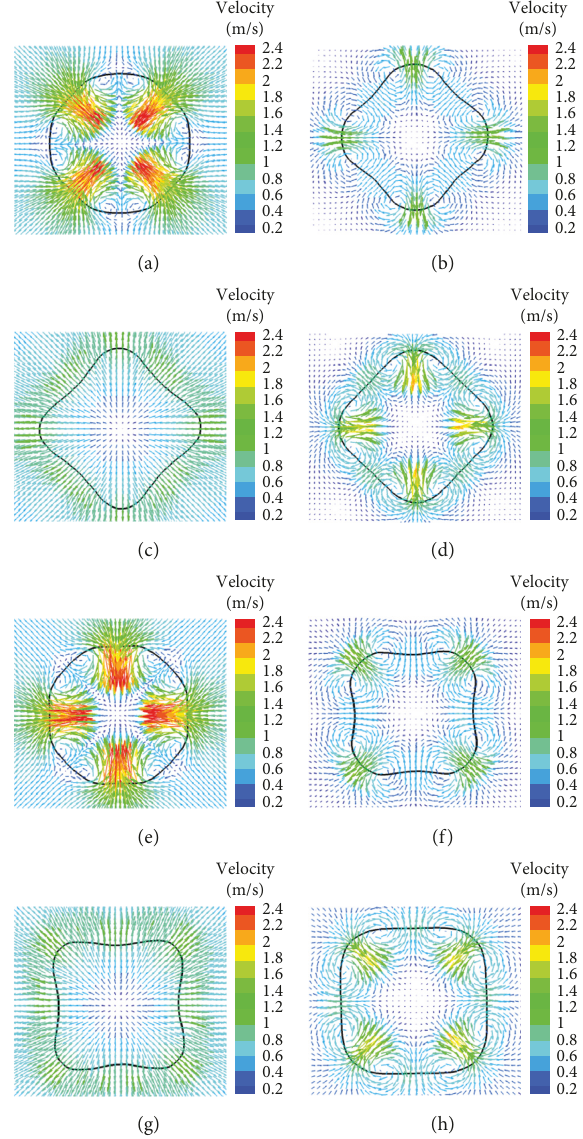
Figure 9: Instantaneous velocity vectors and bubble shapes during a single bubble oscillation period when n � 4. Black solid lines indicate the gas-liquid interface. (a) t ∗ � iT ; (b) t ∗ � ( i +0.25) T ; (c) t ∗ � ( i +0.5) T ; (d) t ∗ � ( i +0.75) T ; (e) t ∗ � ( i +1) T ; (f) t ∗ � ( i +1.25) T ; (g) t ∗ � ( i +1.5) T ; (h) t ∗ � (i +1.75) T